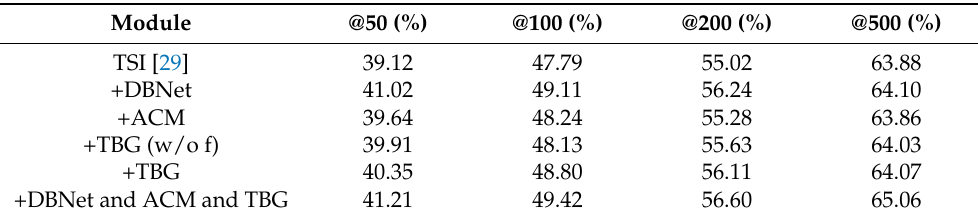
Table 3. Ablation study on the performance of the proposed module on the THUMOS14 dataset, measured by AR@AN. “f” is the proposed feature aggregation function.